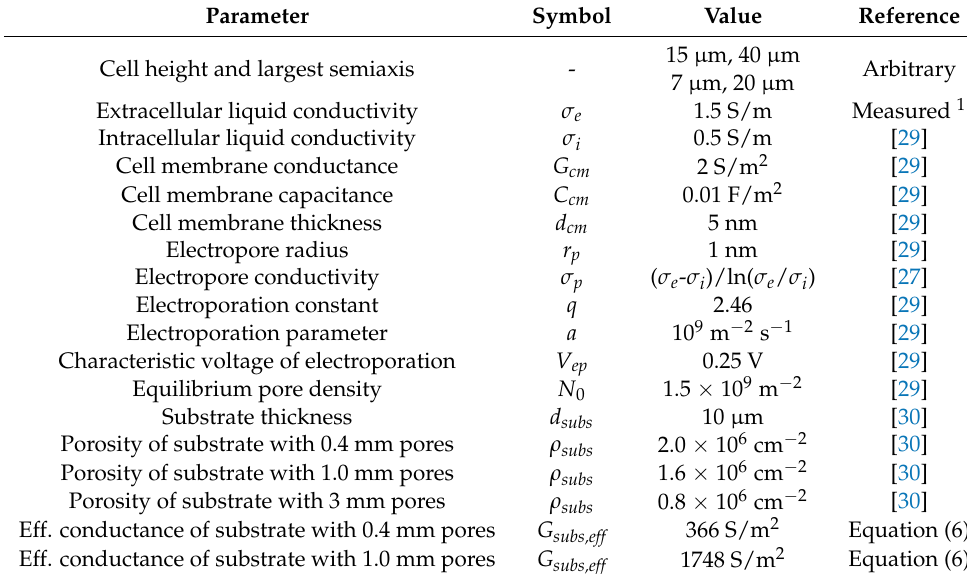
Table 1. Values of model